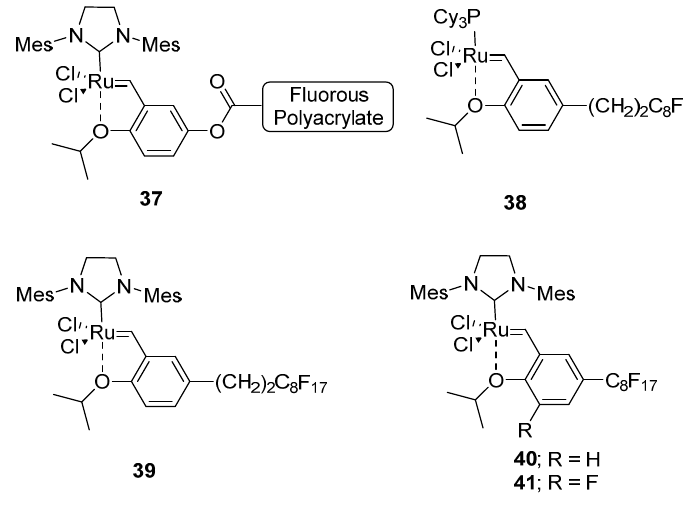
Figure 7. Fluorous-tagged ruthenium catalysts 37 – 41 .